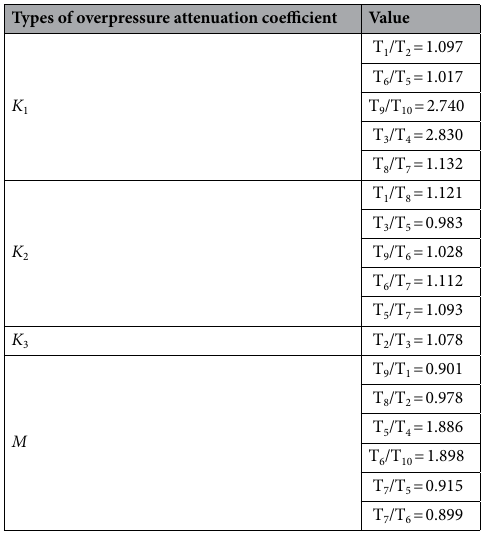
Table 2. Overpressure attenuation coefficient at each monitoring